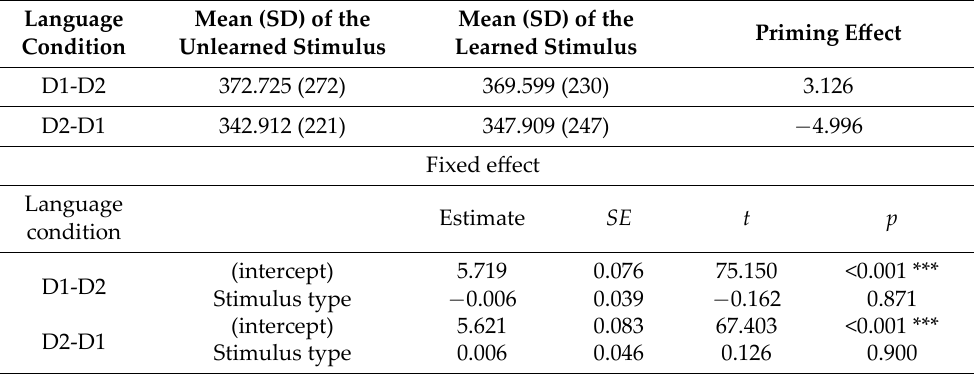
Table 3. Reaction times and the mixed‑effects modeling results for experiment